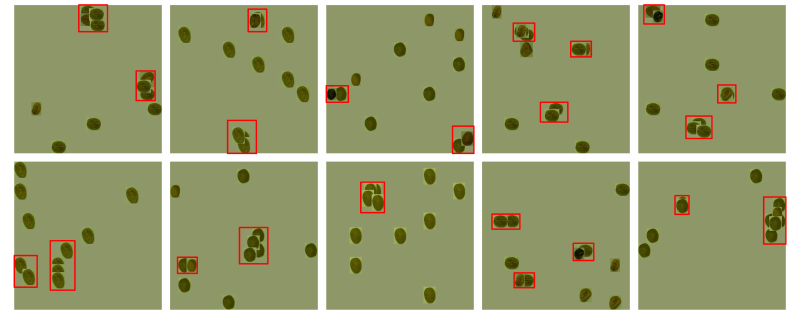
Figure 10. Some instances of heavily bean-overlapping images that are discarded. The overlapping area of beans is marked in red